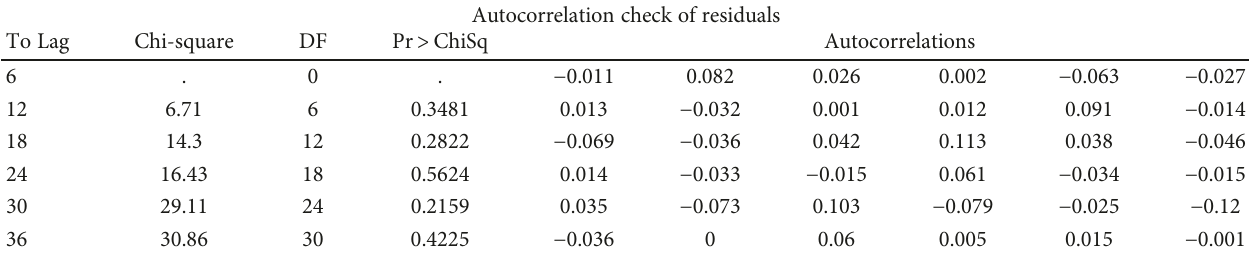
Table 12: Ljung-Box test results for ARIMA modeling of corn prices.